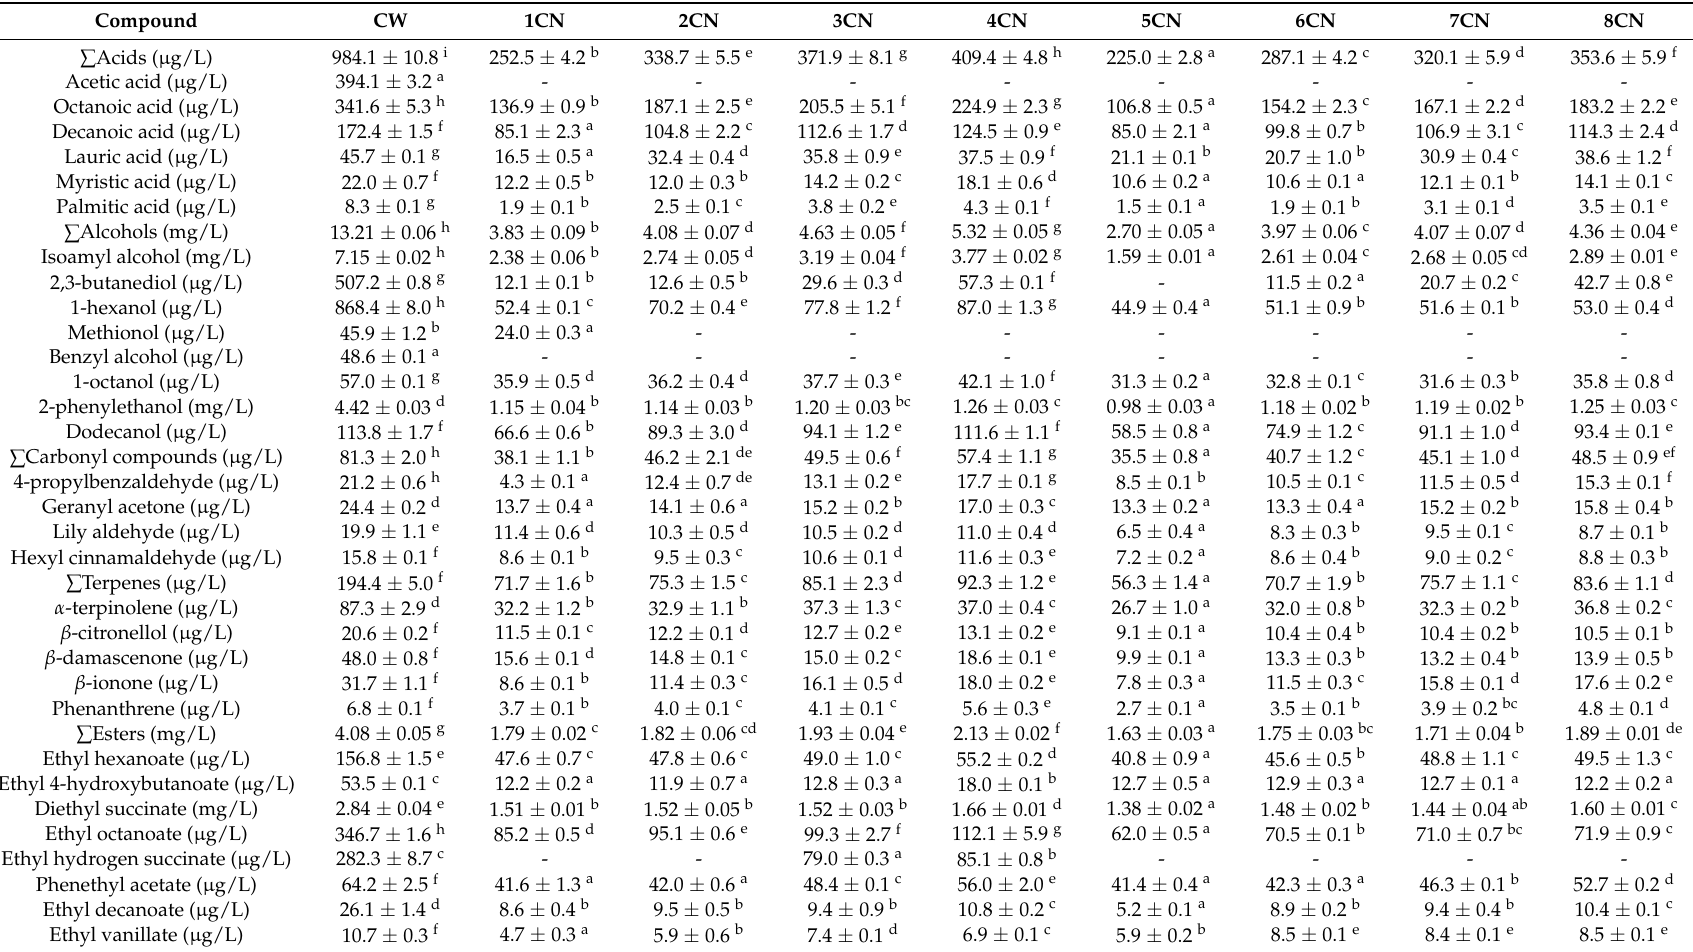
Table 3. Volatile compounds identified in conventional Cabernet Sauvignon red wine and nanofiltration retentates at 2.5, 3.5, 4.5 and 5.5 MPa with cooling and without cooling. Different superscript letters (a, b, c, d, e, f, g, h, i) in the same row represent statistical difference by ANOVA, Fisher’s (LSD) test ( p < 0.05).